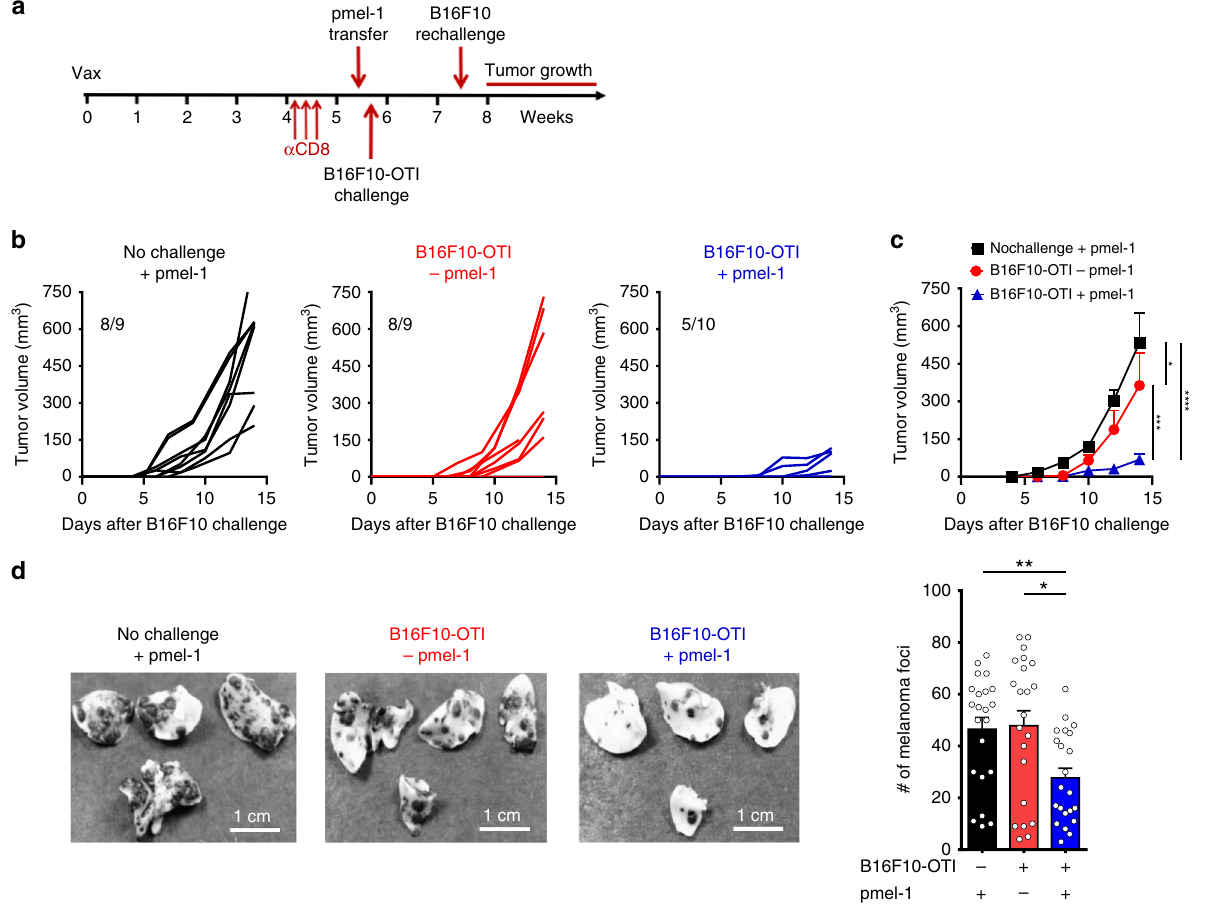
Fig. 5 Trm cell-induced antigen spreading suppress melanoma growth. C57BL/6 mice bearing OVA-speci fi c skin Trm cells and depleted of circulating CD8 + T cells were intravenously transferred with gp100-speci fi c CD90.1 + pmel-1 CD8 + T cells and one day later challenged intradermally with B16F10- OTI cells (B16F10-OTI + pmel-1). Control groups were not challenged but received pmel-1 CD8 + T cells (no challenge + pmel-1) or challenged but did